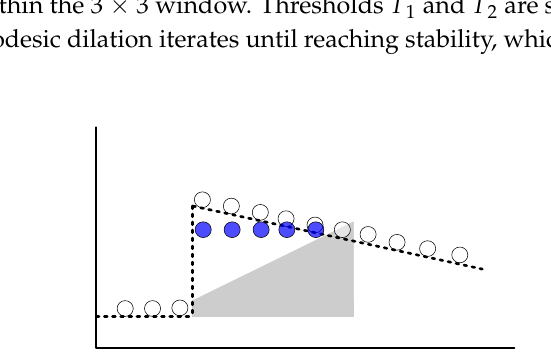
the original ground surface).